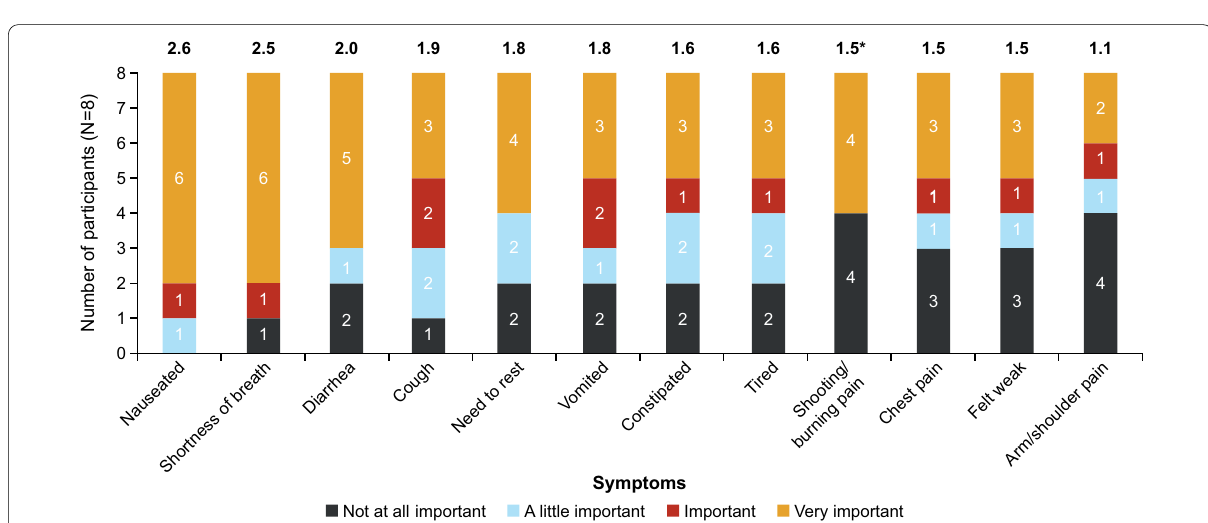
Fig. 4 Importance Rating of Symptoms. Values at the top of each bar denote mean importance rating for that symptom generated from a scoring system of 0 not at all important; 1 a little important; 2 important; 3 very important; therefore, the higher the score, the greater the = = = = importance of the